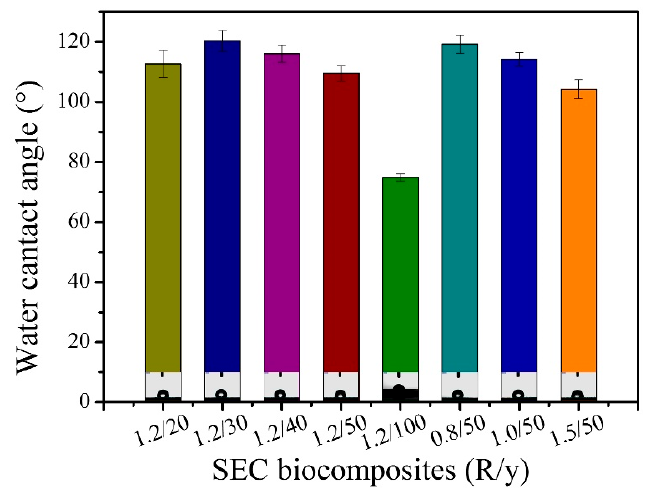
Figure 9. Water contact angles of SEC biocomposites with different R values and ESOCA resin content.